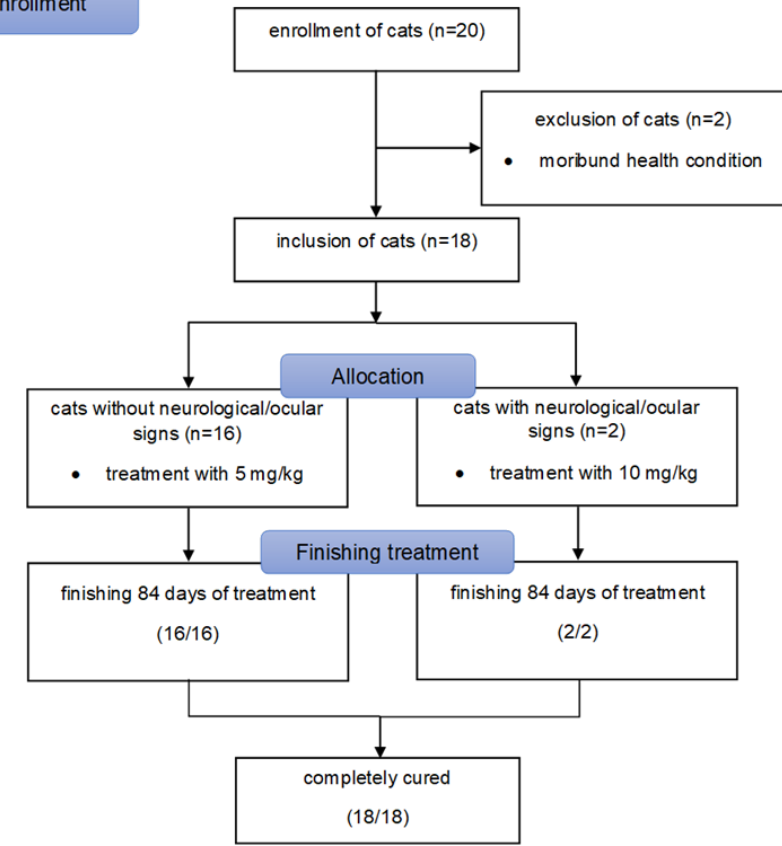
Figure 1. Flow diagram illustrating enrollment, inclusion, allocation process to high-dose treatment (10 mg/kg) for cats with neurological/ocular signs or low-dose treatment (5 mg/kg) for cats without neurological/ocular signs (based on the package inserts, Supplementary File S1), and outcome of cats in the